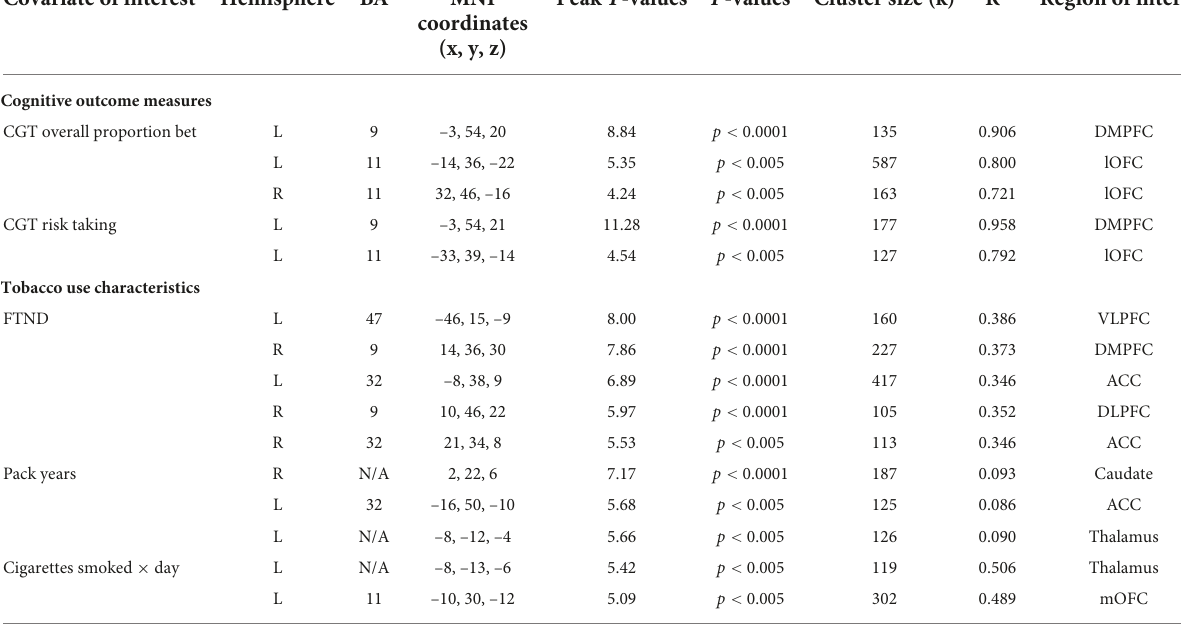
Region of interest